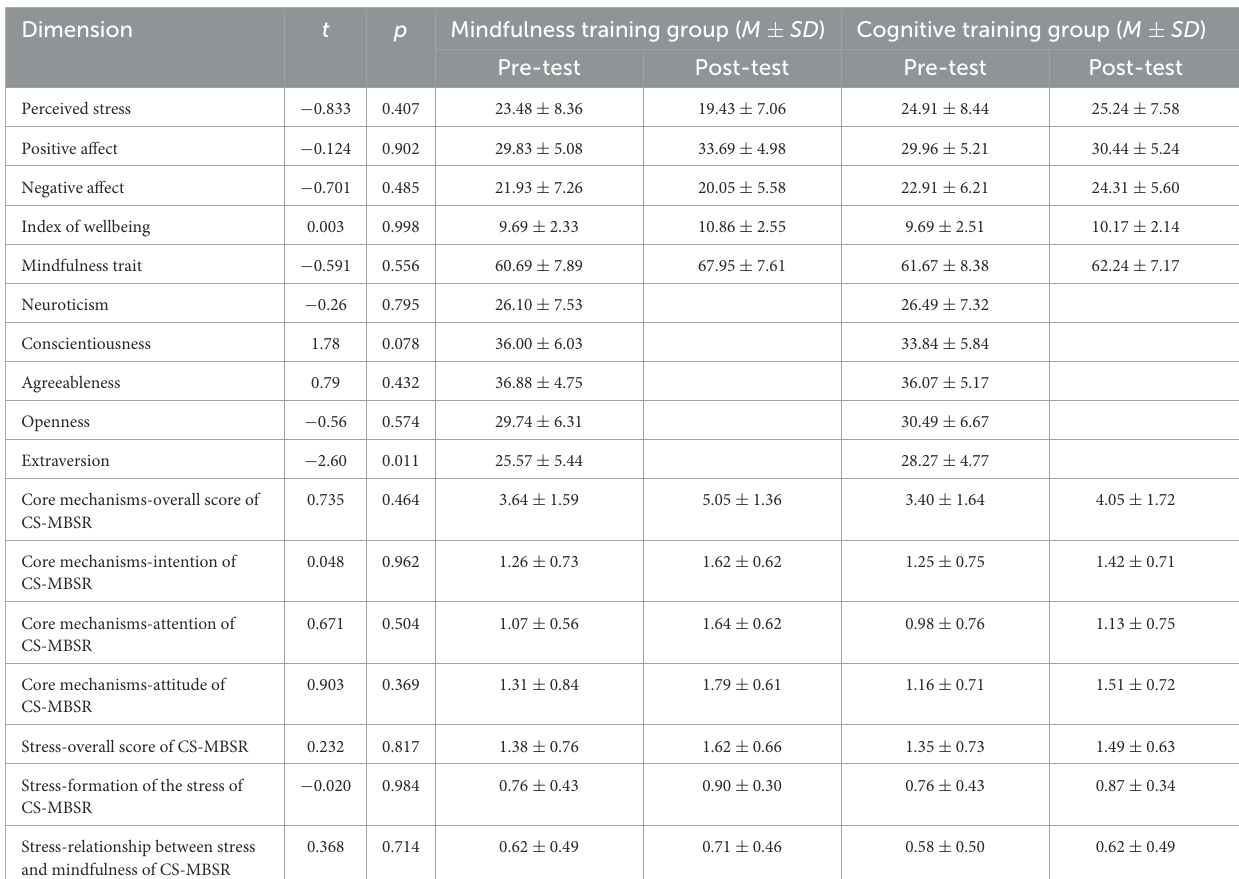
TABLE 5 Baseline tests of psychometric indicators.